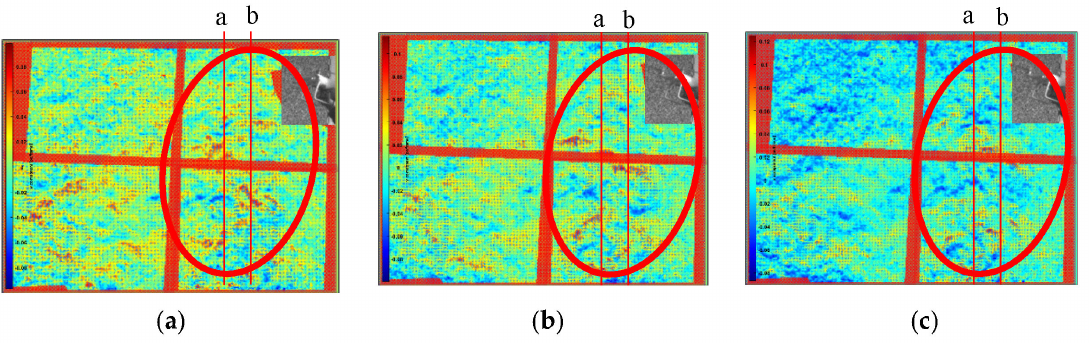
Figure 19. Frame skipping analysis diagram and vertical baseline setting. ( a ) T = frame 570, ( b ) T = frame 595, ( c ) T = frame 620.